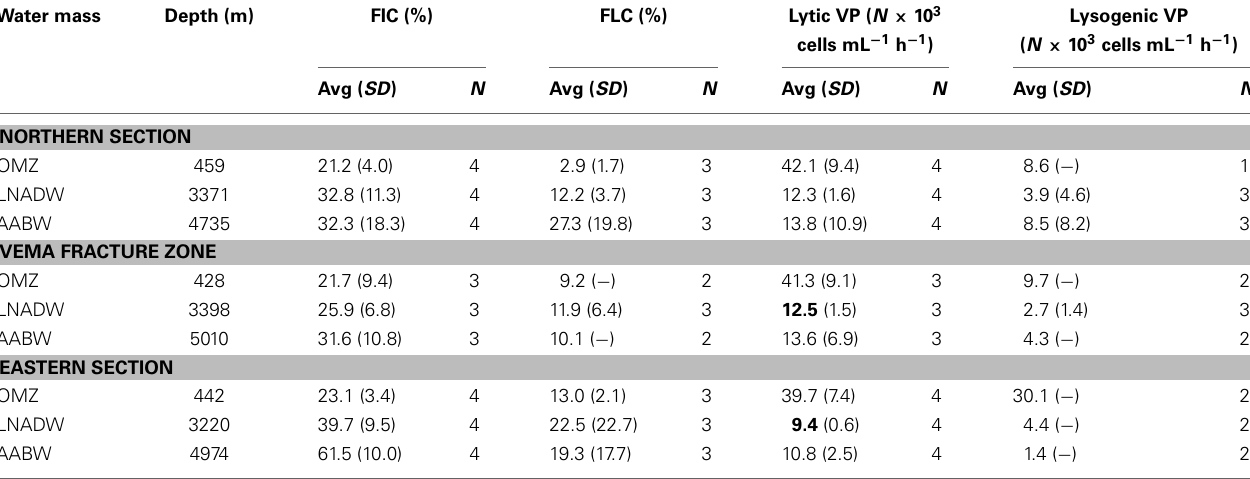
Table 4 | Frequency of infected cells (FIC), frequency of lysogenized cells (FLC), lytic and viral production (VP) rates at different depth layers in the three